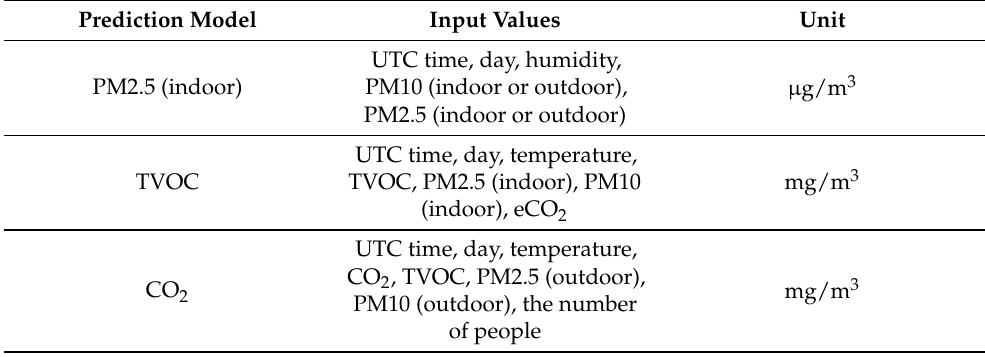
Table 3. Input data of the proposed IAQ prediction